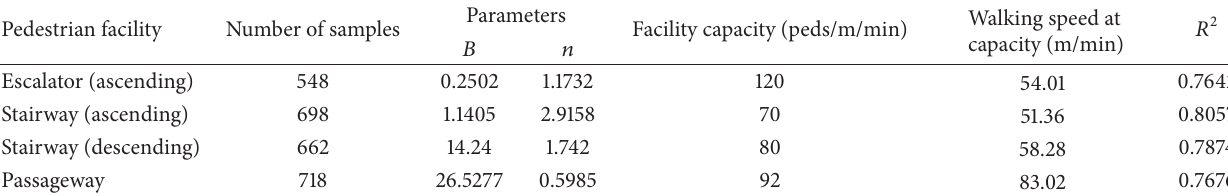
Table 1: Travel time functions of pedestrian